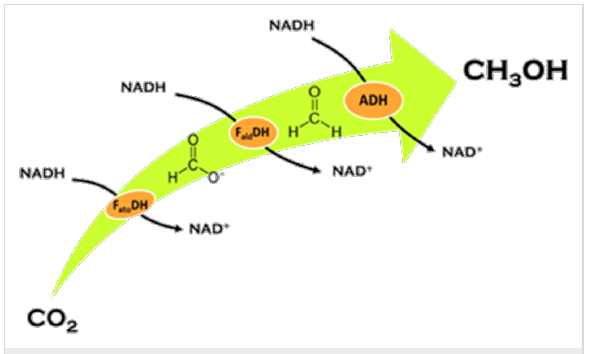
Figure 1: CO 2 reduction to methanol in water promoted by F ate DH, F ald DH and ADH where three consecutive 2e − steps are